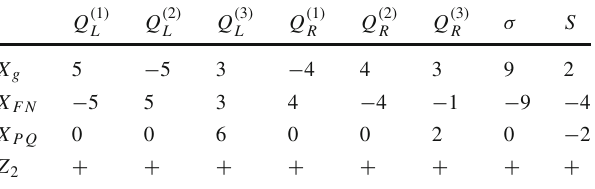
Table 1 The U ( 1 ) g × U ( 1 ) FN charge of the color triplet fermions Q ( i ) and the SM singlet complex scalars σ and S . The charge X PQ of L , R U ( 1 ) PQ is defined as X PQ = X g + X FN where X g and X FN are the chargesof U ( 1